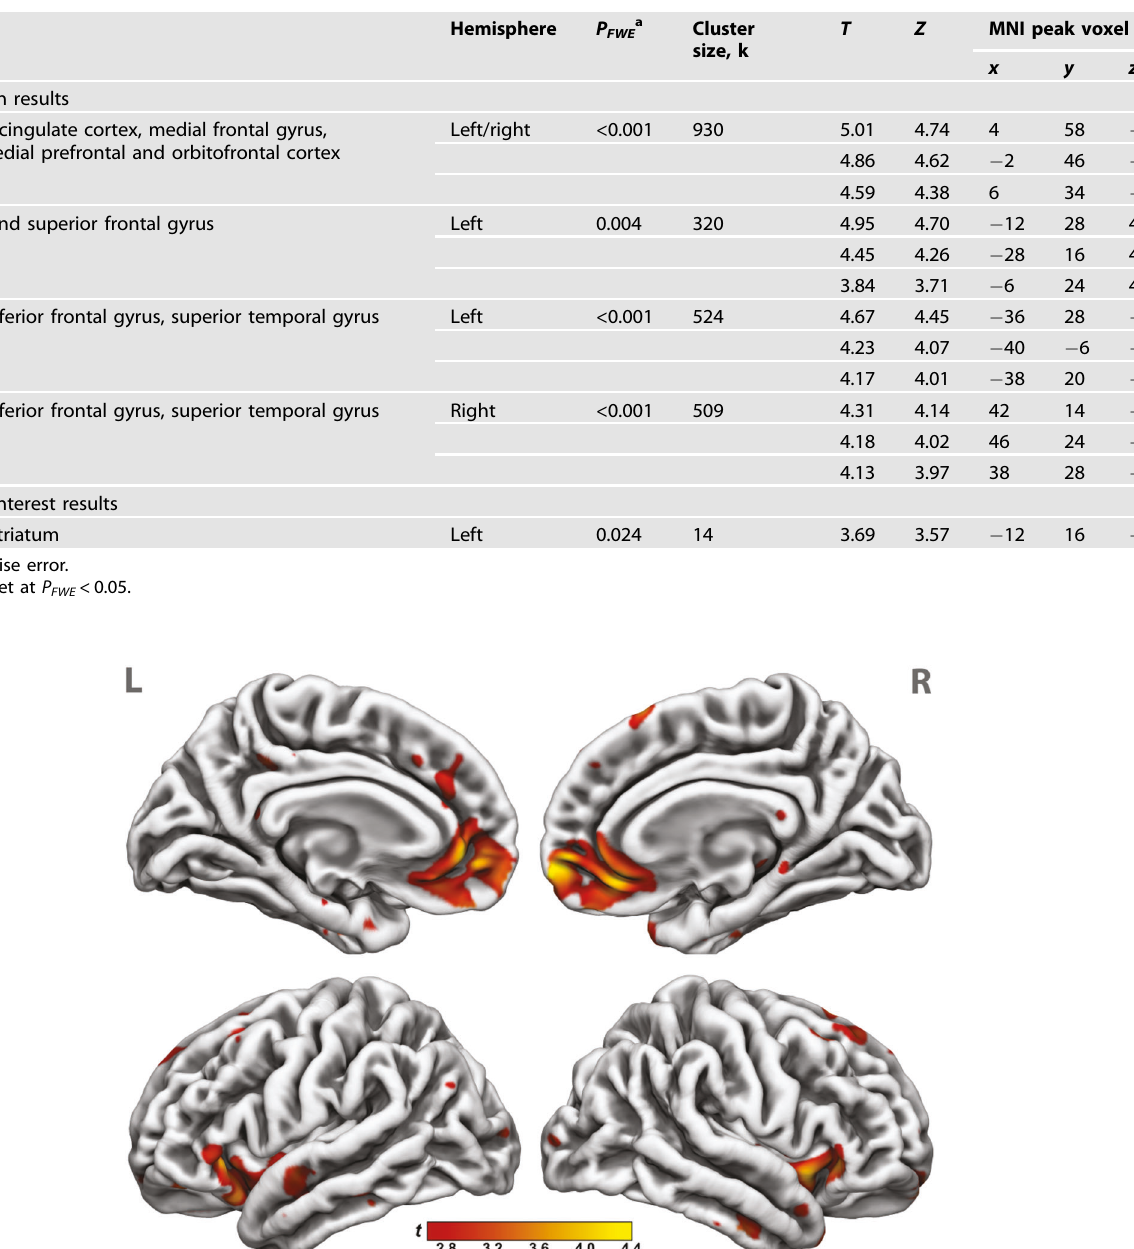
Table 2. Negative association of neural activation to social reward anticipation and childhood maternal antipathy.